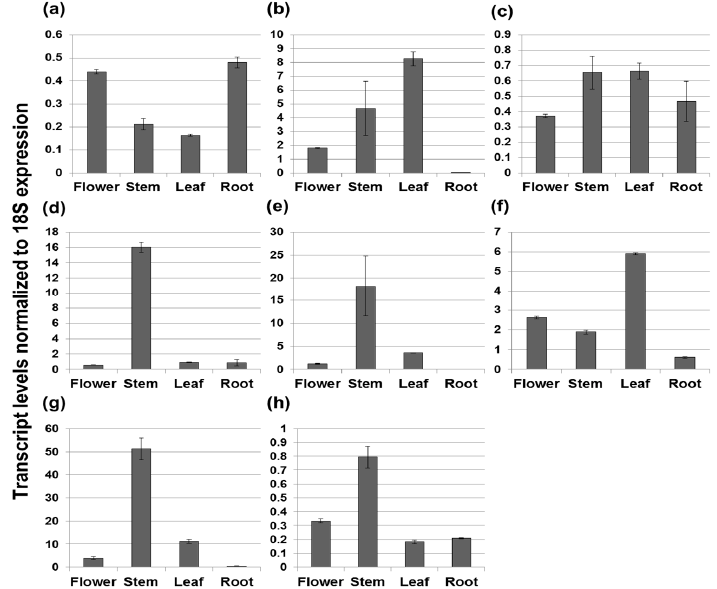
Figure 3. Transcript levels of MEP biosynthetic genes in different organs from V. fauriei ( Vf ). Genes